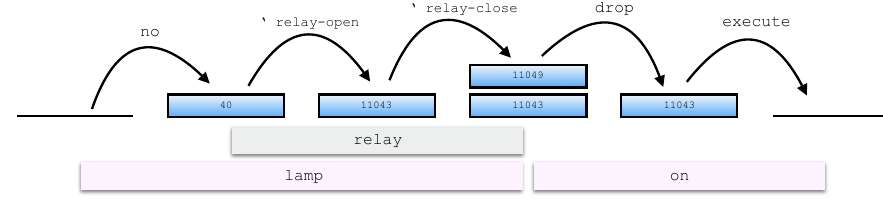
Figure 3. Stack effects of the execution of the sentence lamp on